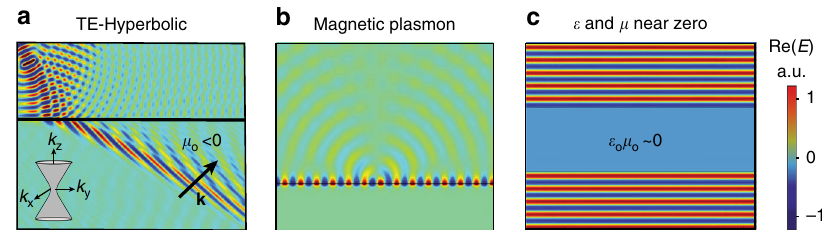
Fig. 1 Implications of magnetic response in a planar geometry. a Transverse electric (TE) negative refraction of phase in a hyperbolic metamaterial with μ o < 0 and μ > 0. The arrow indicates the direction of wavevector and the black line indicates the interface between air and the hyperbolic metamaterial. e Inset: 3D isofrequency diagram for μ o < 0, μ e > 0. b TE magnetic plasmon at the interface between air and magnetic material ( μ < 0), analogous to transverse magnetic polarized surface plasmon polaritons ( ϵ < 0). c ϵ and μ near zero (EMNZ): a fi eld propagating inside an EMNZ slab with